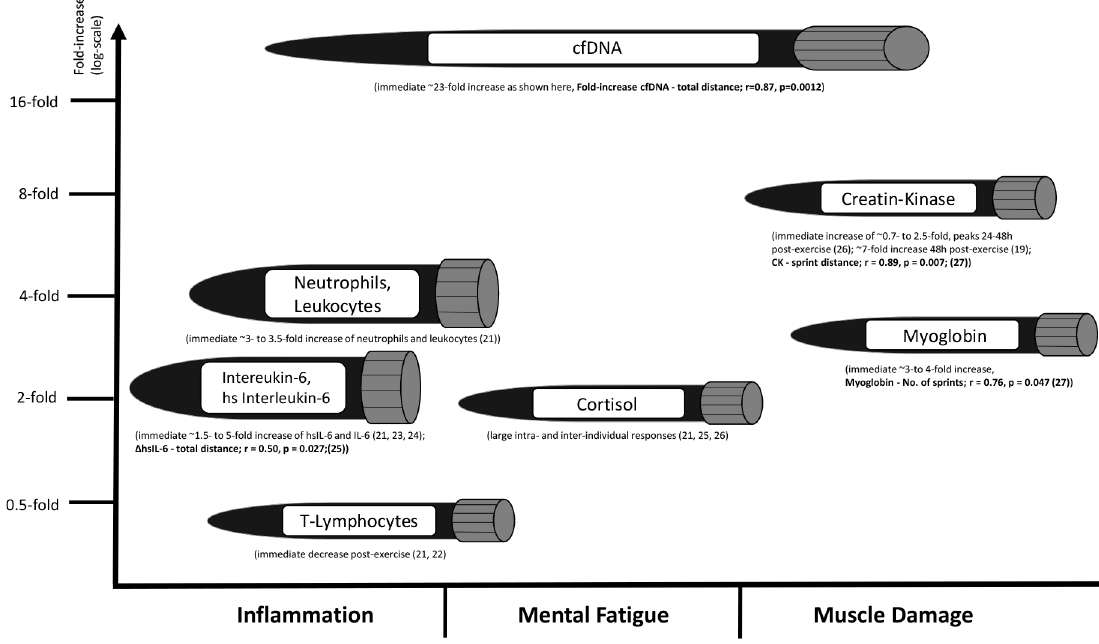
Fig 5. Exercise-induced responses of selected blood parameters due to intermittent exercise. Exercise-induced responses to intermittent sports of selected blood parameters with associated fold-increases and, if already known, the reference to game related aspects in